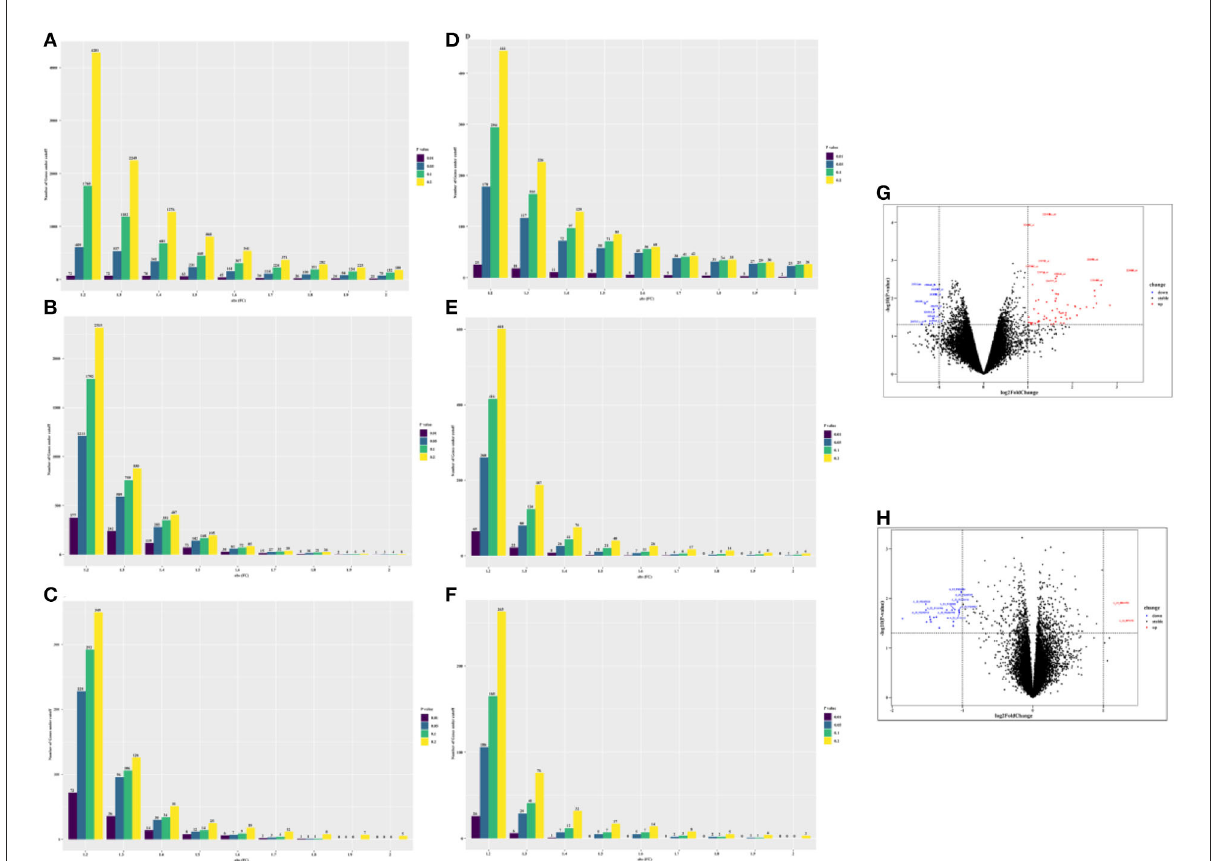
FIGURE3 The number of differentially expressed genes (DEGs) under different thresholds [ p -value and fold change (FC)] and corresponding volcano plot [fold change (FC) ≥ 2 and ≤ − 2, and p -value of < 0.05 were used]. (A) GSE 24752: hypertensive ( n = 3) vs. normotensive ( n = 3). (B) GSE75360: hypertensive ( n = 10) vs. normotensive ( n = 11). (C) GSE71994: uncontrolled hypertensive ( n = 20) vs. controlled hypertensive ( n = 20). (D) GSE74144: hypertensive patient with normal left ventricular ( n = 14) vs. normal control ( n = 8). (E) GSE74144: hypertensive patient with left ventricular remodeling ( n = 14) vs. normal control ( n = 8). (F) GSE74144: hypertensive patient with left ventricular remodeling ( n = 14) vs. hypertensive patient with normal left ventricular ( n = 14). (G) Volcano plot for GSE24752: hypertensive ( n = 3) vs. normotensive ( n = 3). (H) Volcano plot for GSE74144: hypertensive patient with normal left ventricular ( n = 14) vs. normal control ( n =